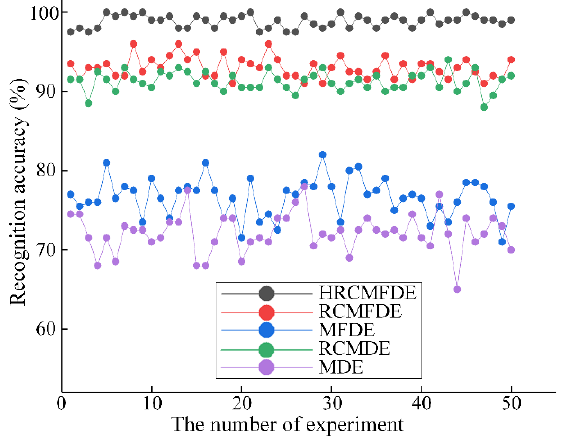
Table 11. Comparison of different models.